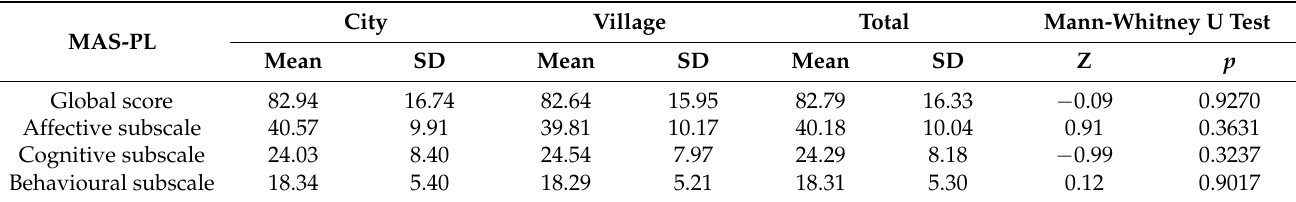
Table 8. Results of the MAS-PL subscales relative to the place of